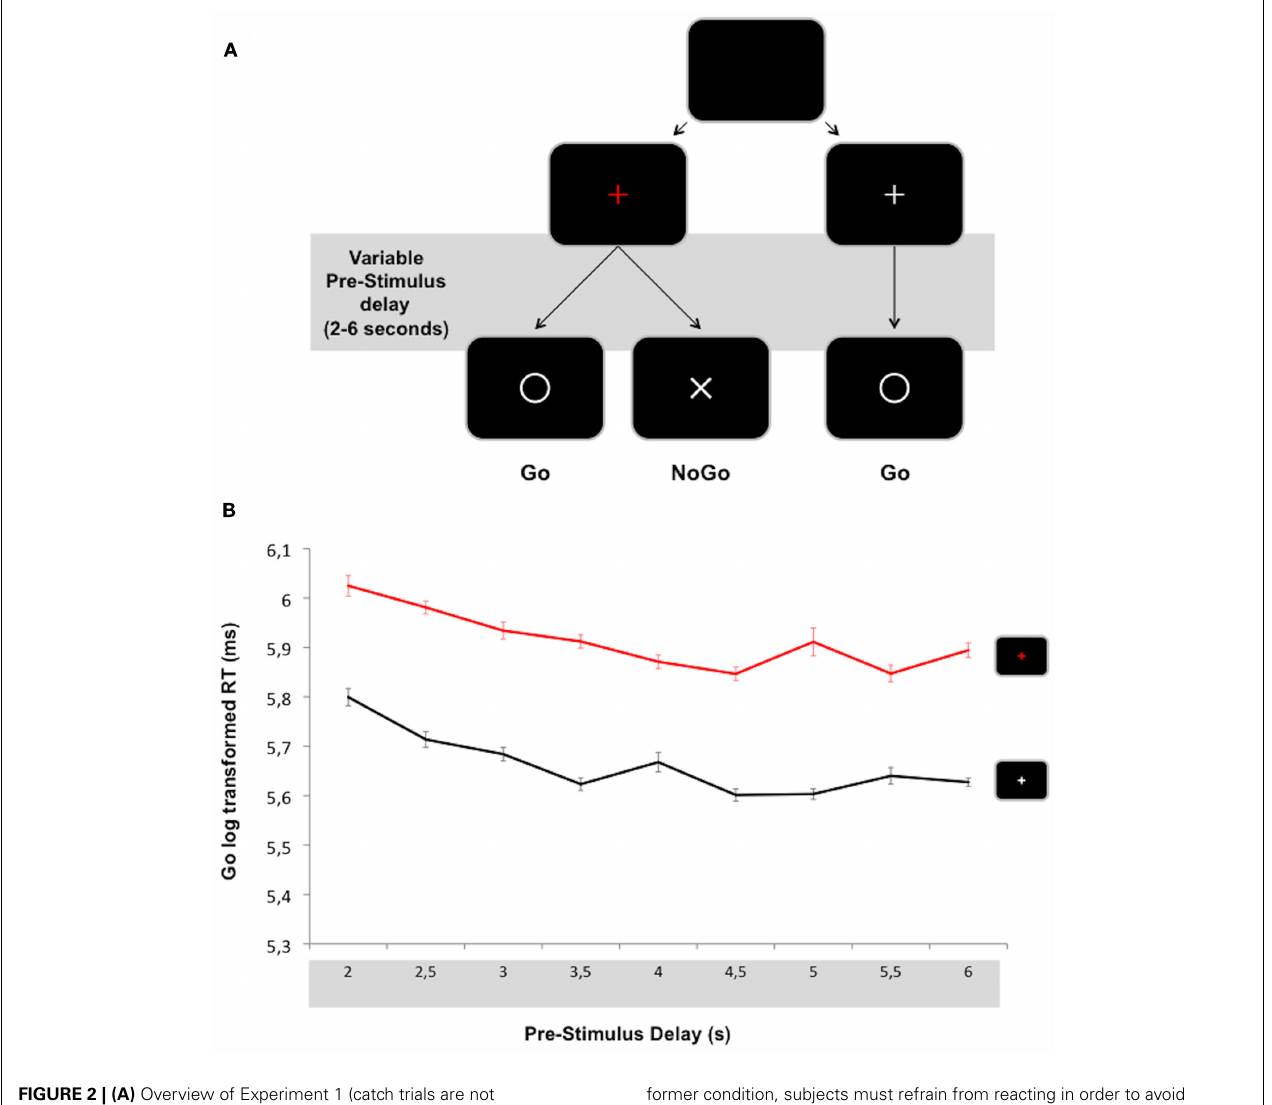
FIGURE 2 | (A) Overview of Experiment 1 (catch trials are not represented). Subjects are instructed to react to the presentation of a go signal (O) by pressing a button as fast as possible. At the beginning of a trial, the central fixation point ( + ) turns either red or white, indicating respectively that nogo stimuli (X) can or cannot be presented. In the